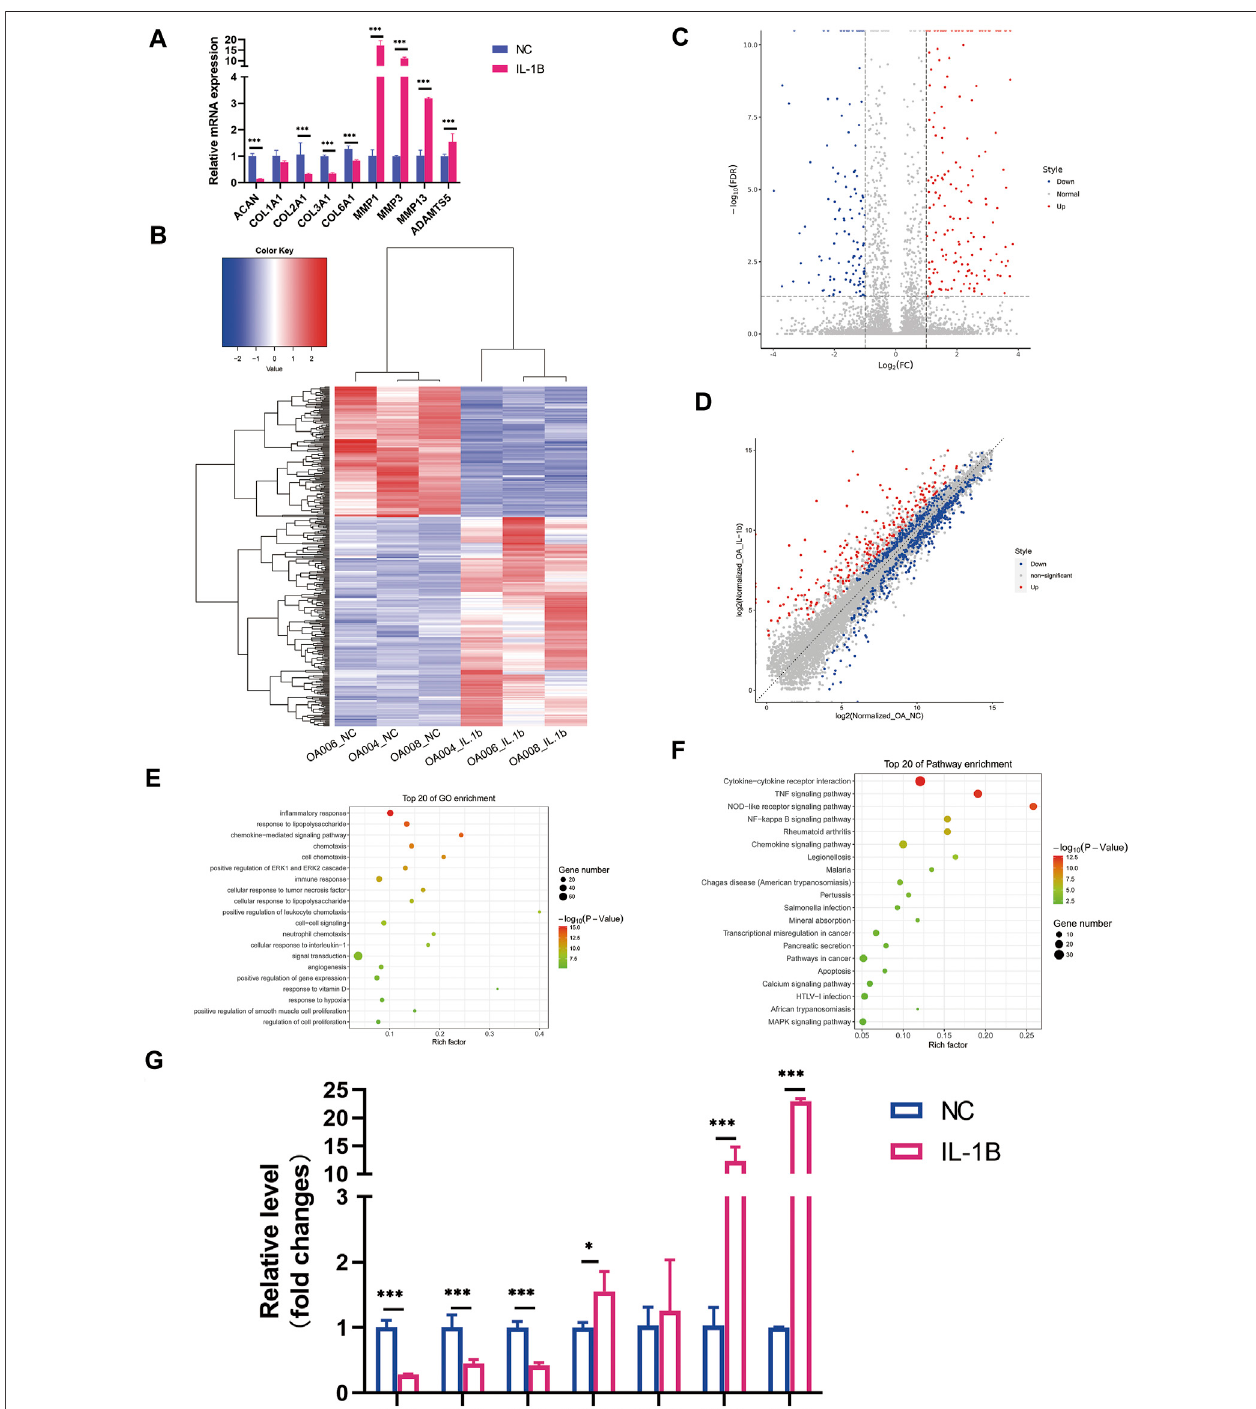
FIGURE1| Differentialexpressionpro fi leofmessengerRNA(mRNA) betweendegenerativemenisciwithandwithoutIL-1 β stimulation. (A) Theexpression pattern of meniscus marker genes and in fl ammatory marker genes in meniscus cells treated with IL-1 β (5 ng/ml) as determined by qRT-PCR analysis. GAPDH was used as the internalreferencegene forqRT-PCRrelativeexpression. Errorbars revealthe standard deviation or thestandard errorofthe data. Student ’ s ttest and Mann – Whitney U test were used to identify signi fi cant differences between groups, where appropriate. * p < 0.05, ** p < 0.01, *** p < 0.001. (B) Hierarchical clustering illustrates distinguished expression difference of mRNA between the two groups and homogeneity between groups. (C) Volcano plot of differentially expressed mRNAs. (D) Scatter plot of differentially expressed mRNAs. (E) The 20 most enriched Gene Ontology (GO) terms for differentially expressed mRNA in degenerative menisci treated